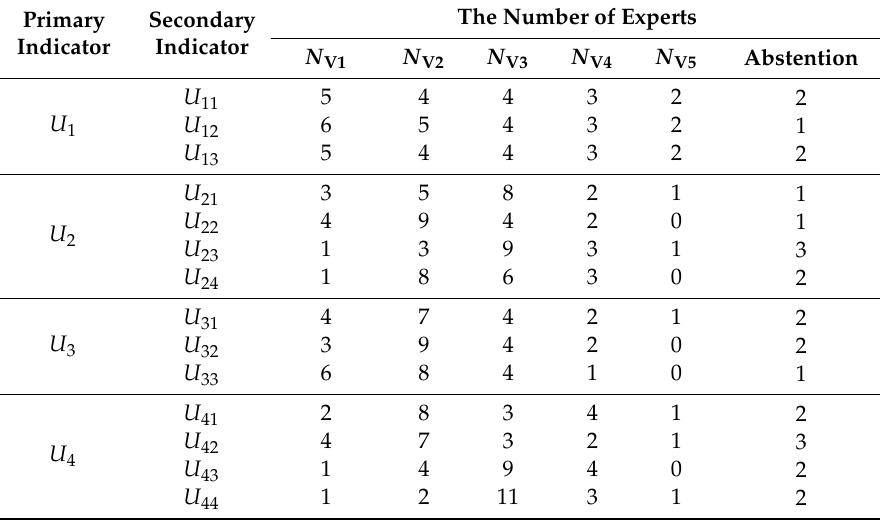
Table A4. Expert evaluation results of secondary